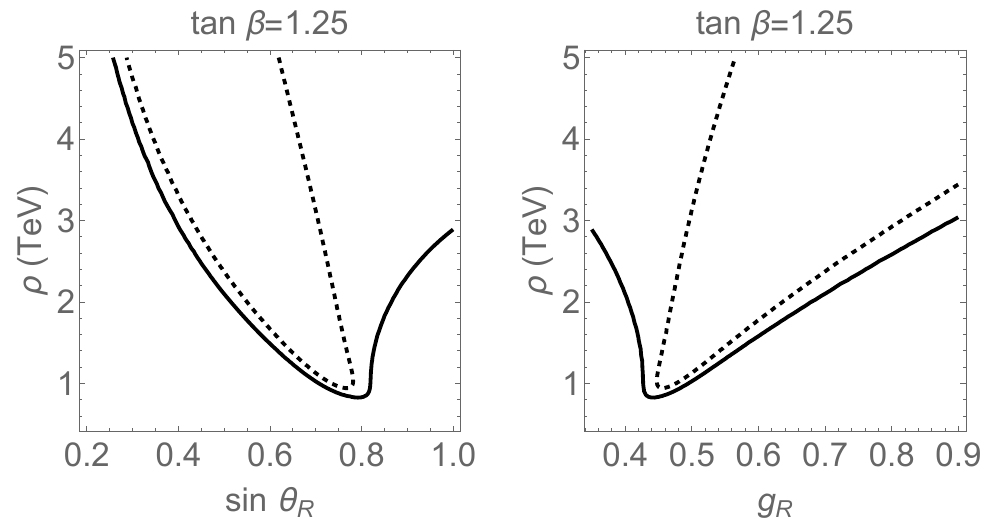
Figure 12 . χ 2 distribution in the plane ( s R , ρ ) (left panel) and ( g R , ρ ) (right panel) for the value of t β = 1 . 25 . The solid (dashed) lines are the corresponding 95% (67%) C.L. limits. where the prime stands for d